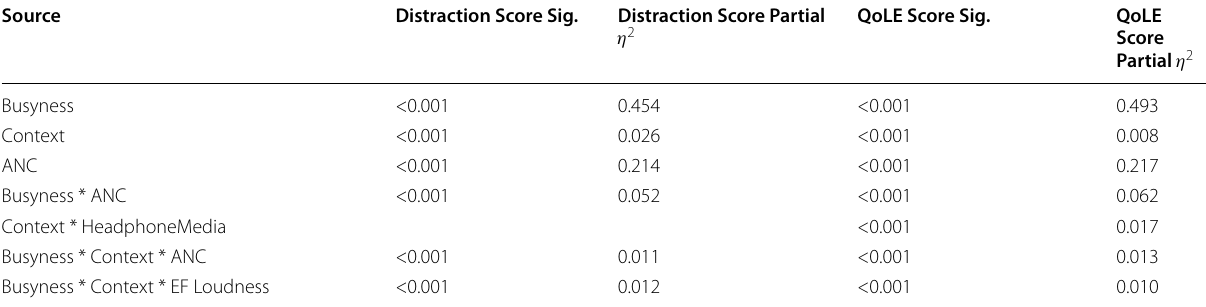
Table 4 The statistical significance and partial η 2 values resulting from the analysis of variance for the distraction scores and QoLE, where the statistical significance was <0.001 Source Distraction Score